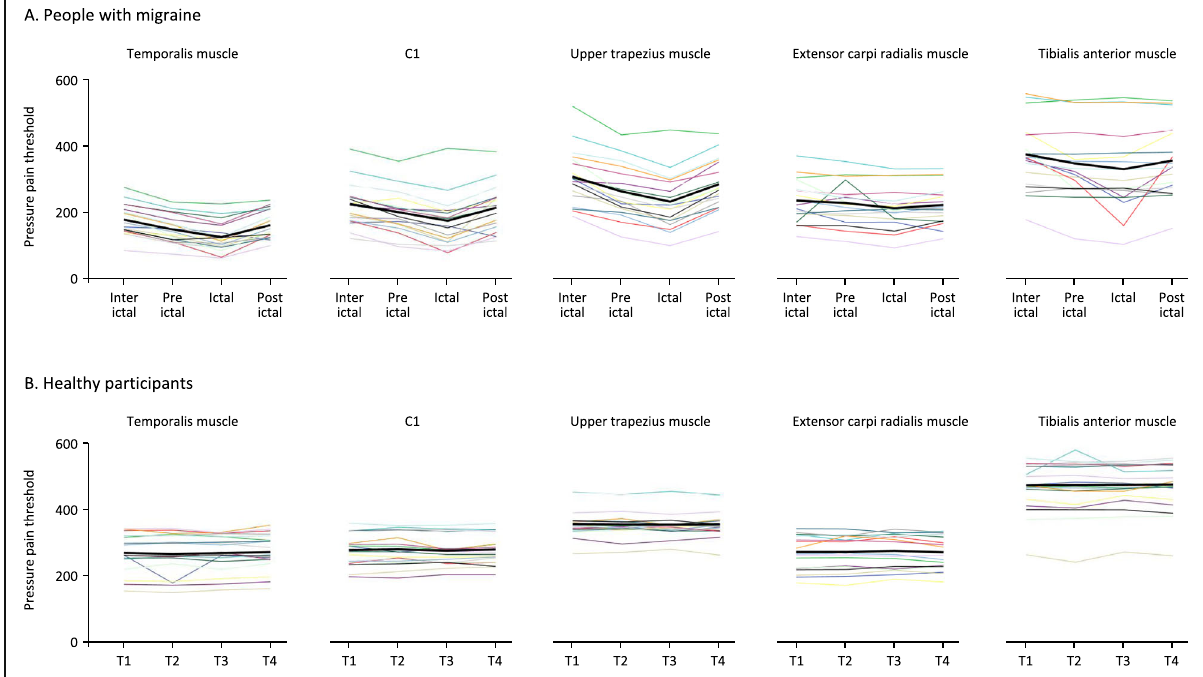
Fig. 2 Individual pressure pain thresholds for the three cephalic regions (temporalis muscle, C1 and upper trapezius muscle) and two extra- cephalic regions (extensor carpi radialis and tibialis anterior muscle) on the dominant side for the four phases of the migraine cycle for people with migraine. Healthy participants were measured at corresponding time intervals (T1 ≙ interictal, T2 ≙ preictal, T3 ≙ ictal, T4 ≙ postictal). Thin lines represent individual participants. The bold black line represents the